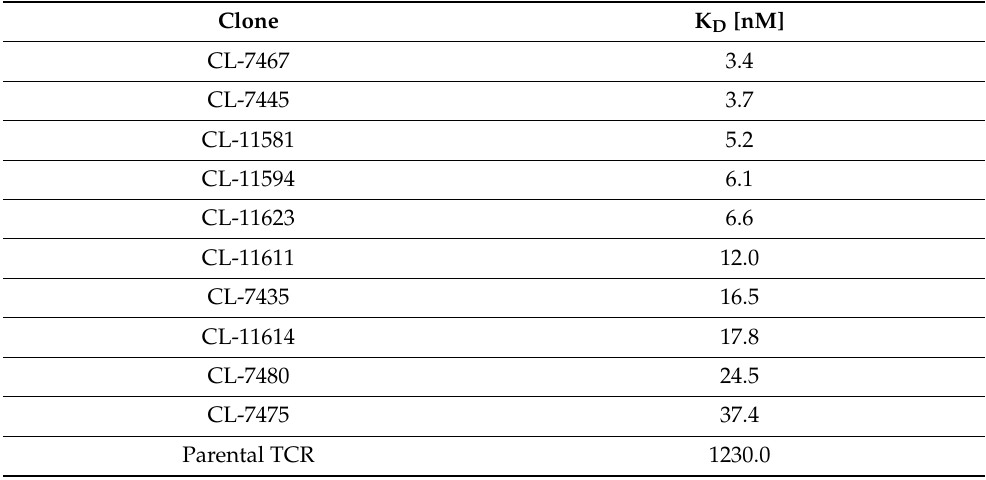
Table 4. PRAME pHLA binding affinity of selected soluble TCER candidates in comparison to the wild type CDR-harboring parental TCR expressed as a single chain TCR construct.